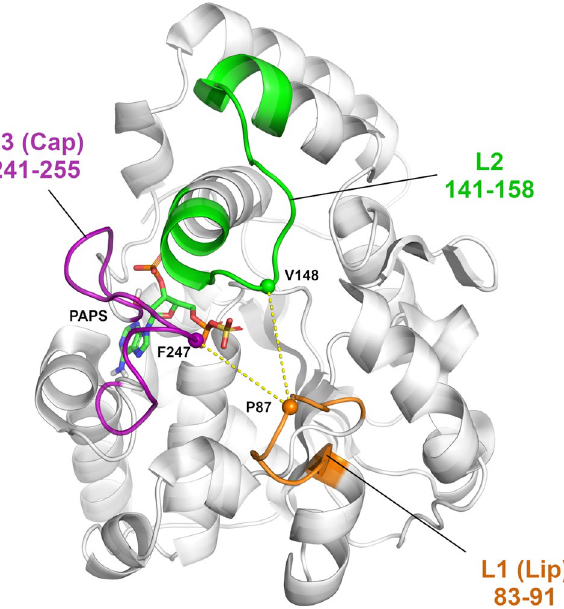
Figure 1. Crystal structure of SULT1A1*1, PDB ID: 4GRA 24 . PAP of 4GRA was replaced by PAPS which was retrieved from the structure of SULT1E1 (PDB ID: 1HY3 47 containing PAPS) and inserted on the same